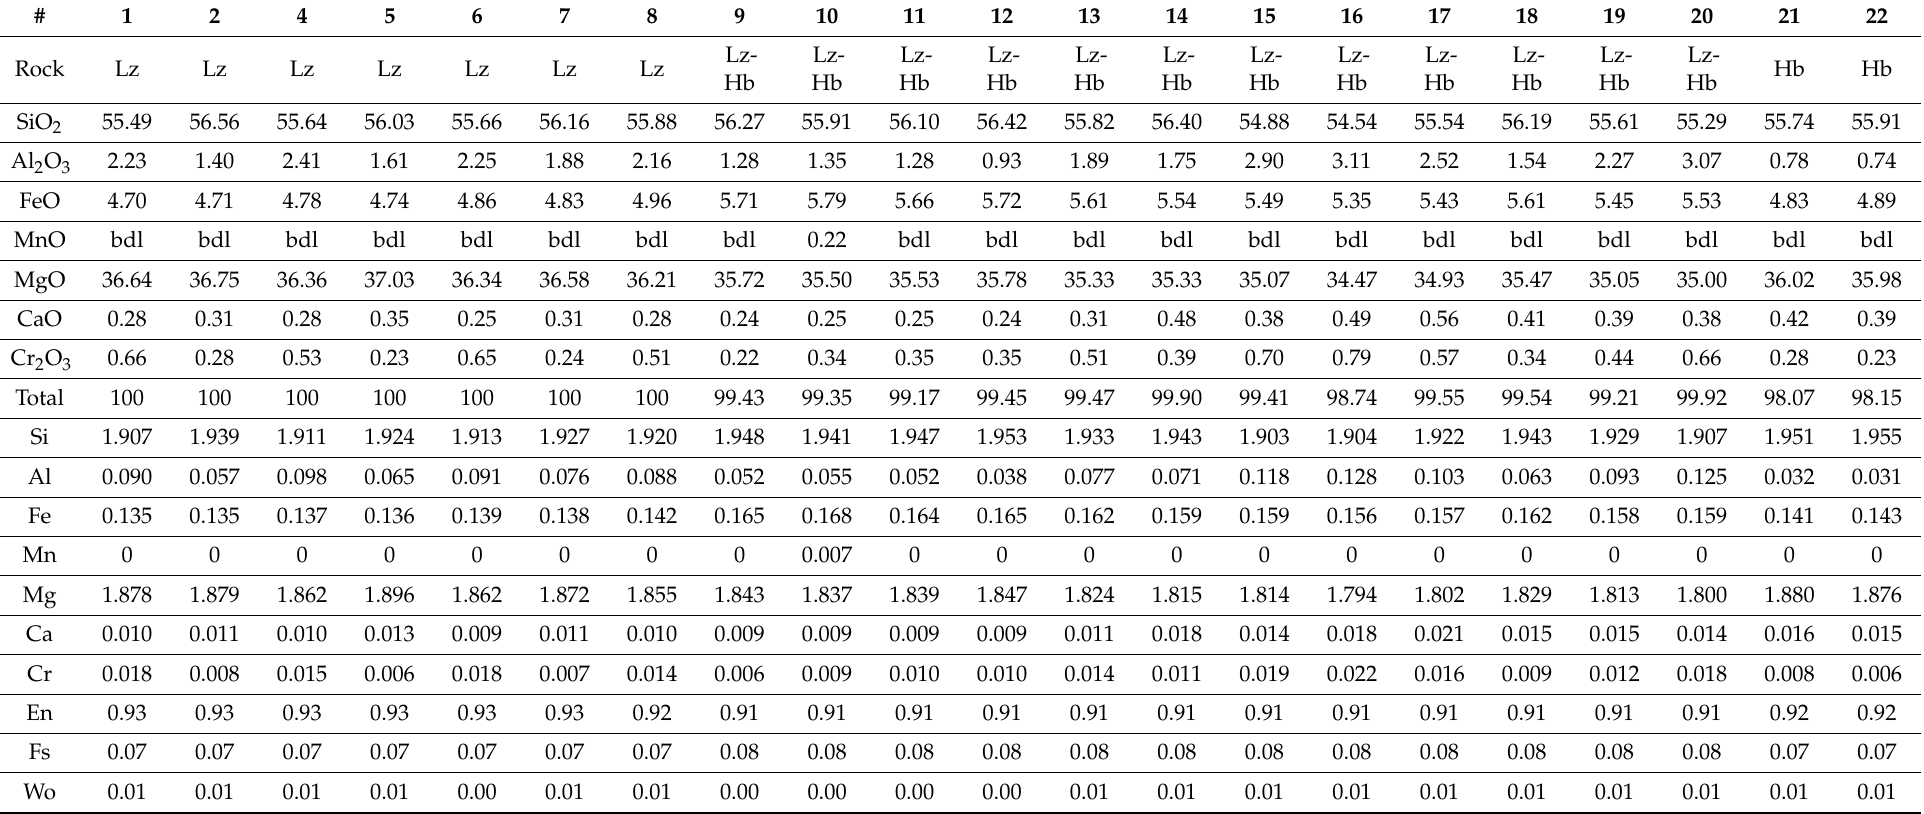
Table 3. Composition of orthopyroxene grains in peridotite of Kempirsay massif